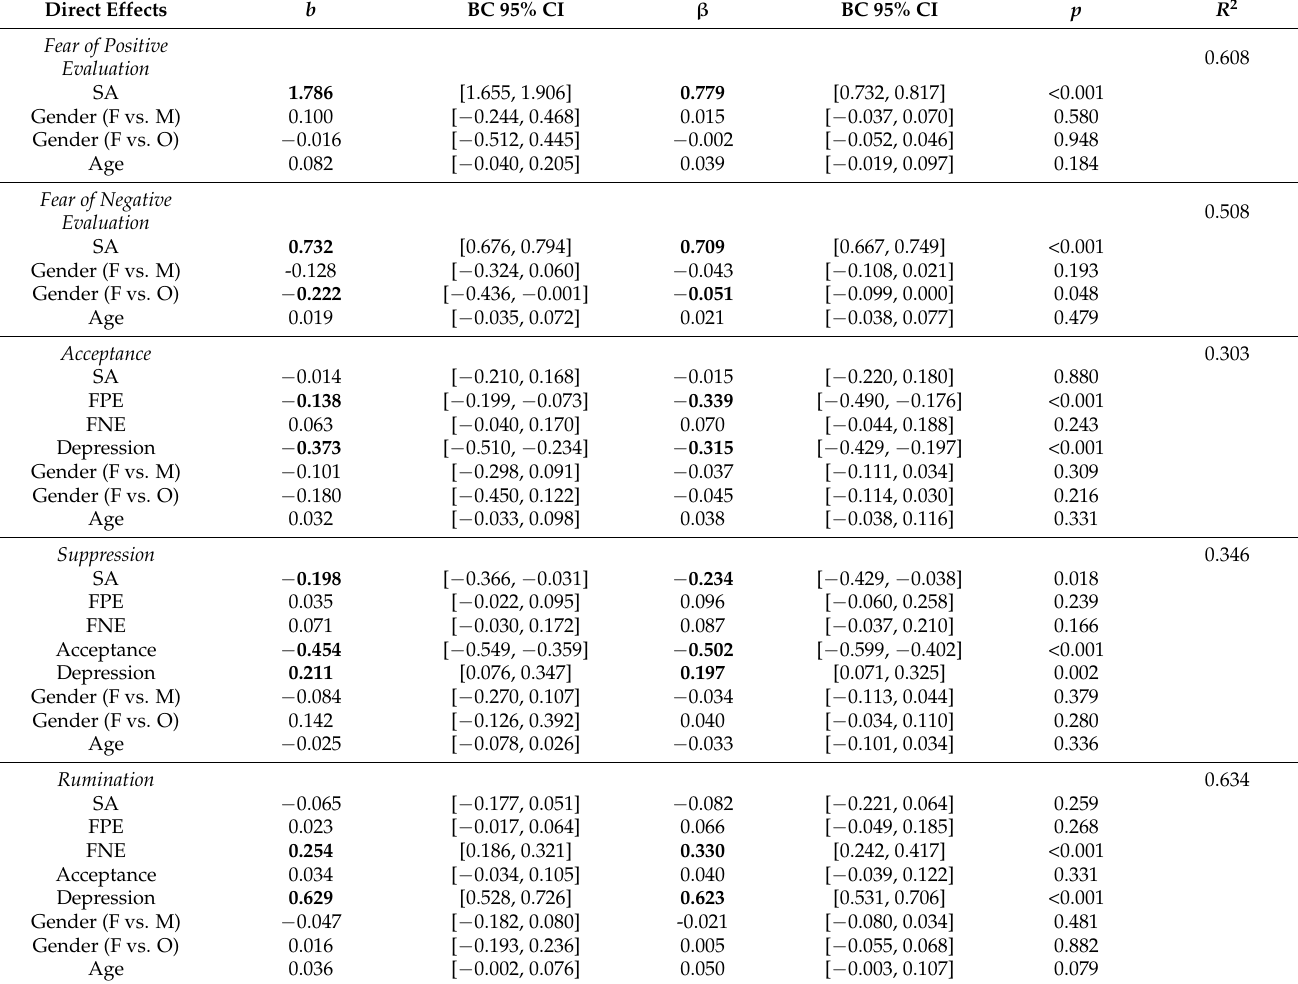
Table 4. Direct effects of the structural equation